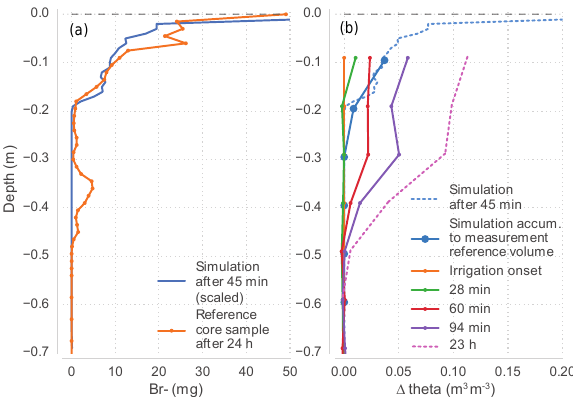
Figure 10. Simulated and observed tracer (a) and soil moisture pro- files (b) in the irrigation experiment. Tracer mass scaled to core sample volume and total irrigation after